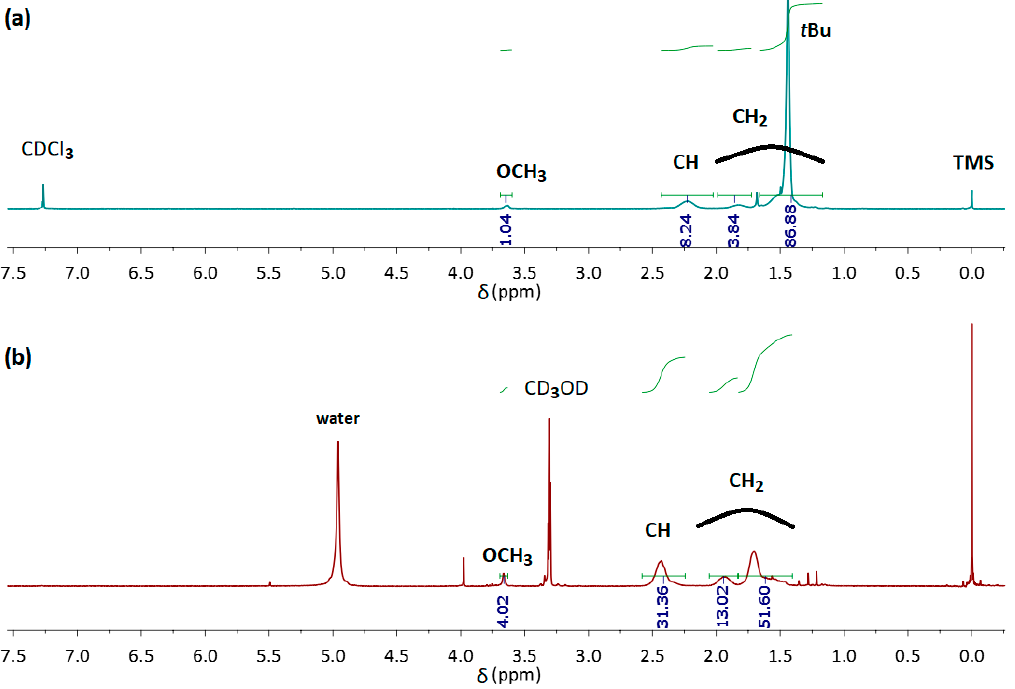
Figure 7. 1 H nuclear magnetic resonance (NMR) (600 MHz) spectra of star-shaped P( t BuA- co -MA) in CDCl 3 ( a ) and the product of its acidolysis S1 in CD 3 OD ( b ).